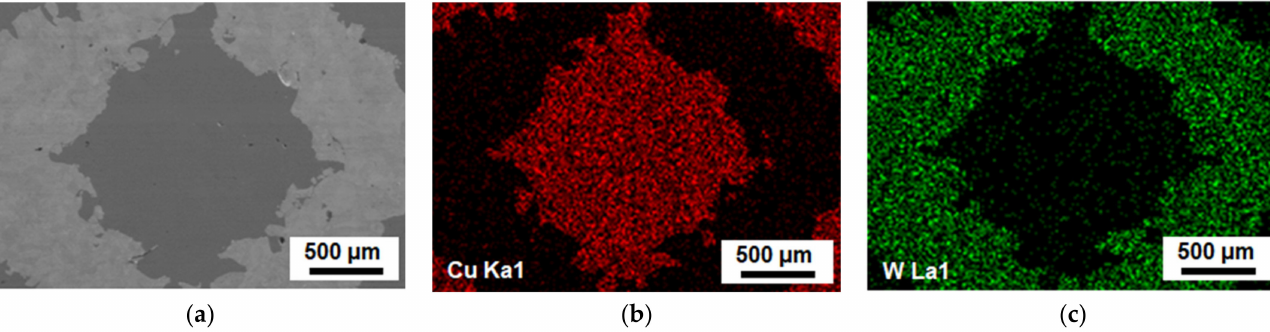
Figure 4. SEM micrographs ( a ) and EDS analysis ( b , c ) of the Cu-W composite with a rhombic